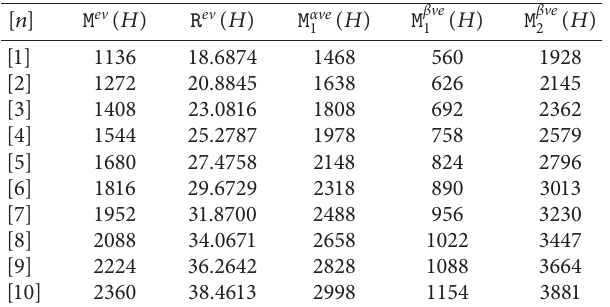
Table 9: Numerical representation of the computed indices for certain values of n .